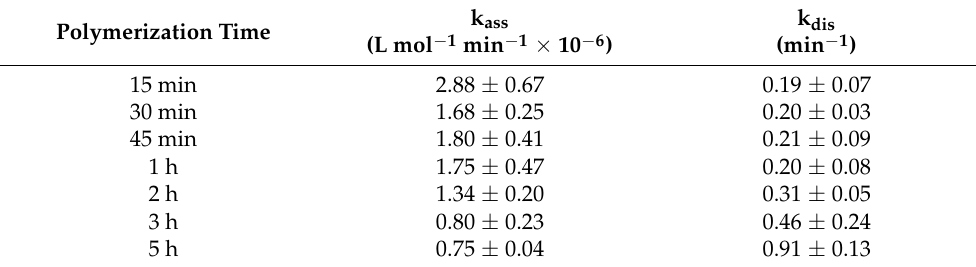
Table 3. Association and dissociation rate constants ( ± 1 standard error unit) measured for ciprofloxacin on ciprofloxacin-imprinted nanoMIPs.